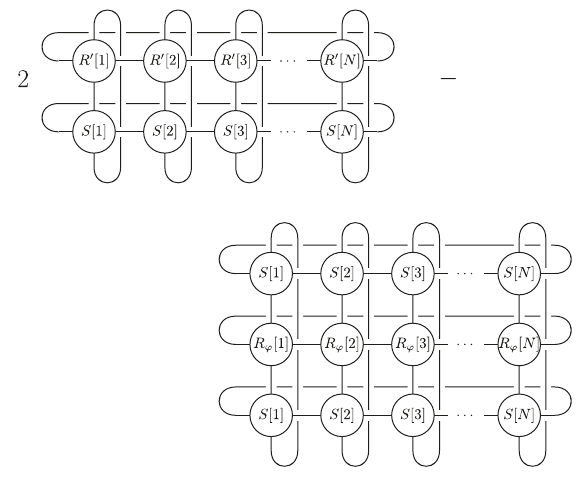
Maximization of the FoM over L is equivalent to a joint maximization over each tensor S ½ n (cid:4) . We relax this optimization problem by iterating an optimization loop. In the loop we fi rst fi nd the optimal S ½ 1 (cid:4) , then S ½ 2 (cid:4) , and so on up to S ½ N (cid:4) , after which we go back to S ½ 1 (cid:4) . The optimization over each S ½ n (cid:4) is performed with all other tensors fi xed. The loop is repeated until the FoM converges. After fi xing the other tensors, the FoM becomes quadratic in S ½ n (cid:4) and the optimal S ½ n (cid:4) is found as a solution to a linear equation. For de fi niteness, to explain the procedure, we focus on the generic example of S ½ 2 (cid:4) . We start by vectorizing S ½ 2 (cid:4) ! S ½ 2 (cid:4)j i